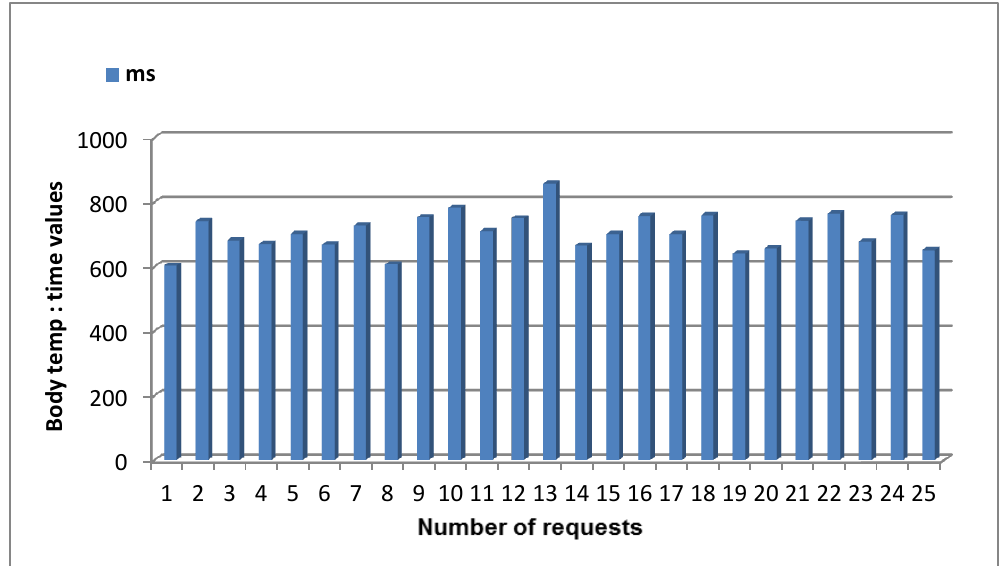
Figure 23. Time used in completing body temperature request (25